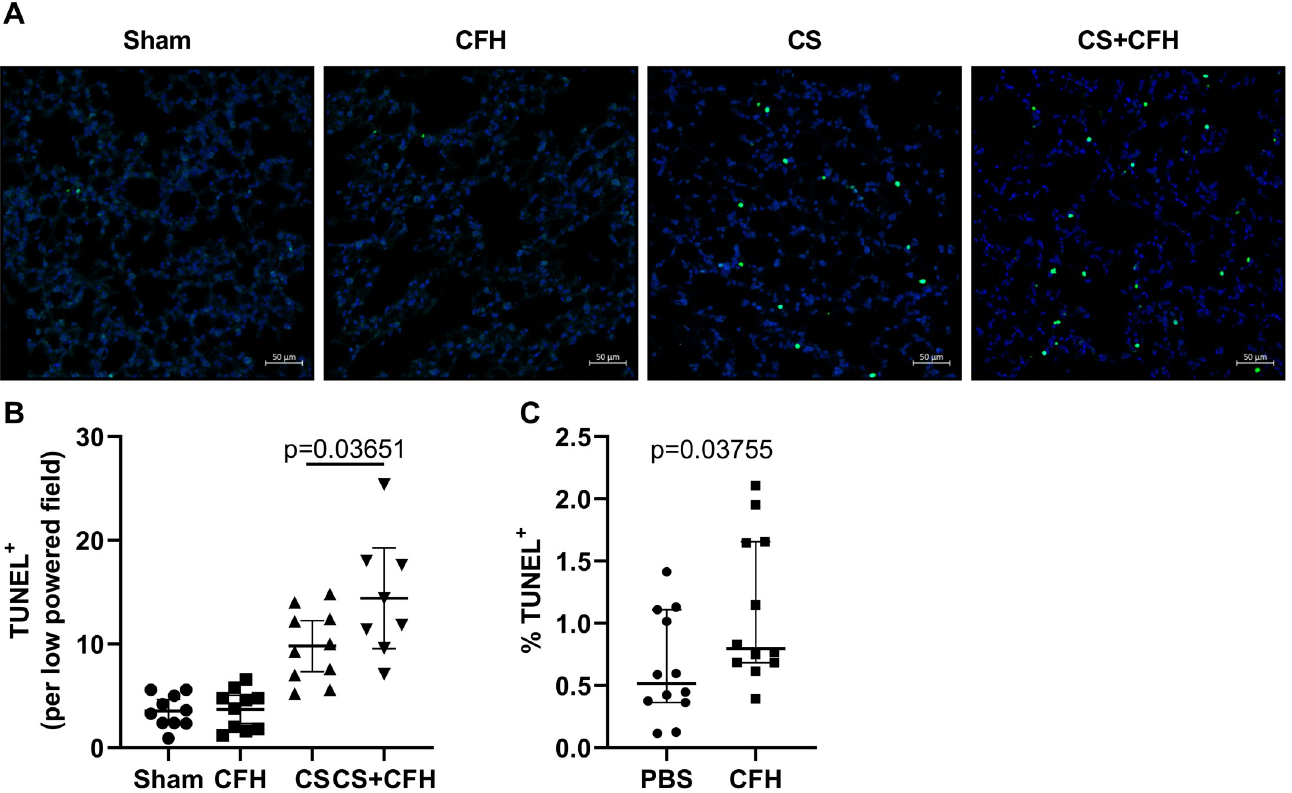
Fig 5. CFH increases lung endothelial apoptosis in sepsis. (A) Formalin fixed mouse lung tissue was stained for TUNEL (green) with nuclear DAPI staining (blue). (B) The number of TUNEL positive cells was higher in CS+CFH versus CS alone by blinded quantification of low powered images (n = 8–10, p = 0.03651). (C) We also assessed apoptosis by TUNEL staining of HULECs in culture and found that CFH (1 mg/mL) treatment induced apoptosis at 4 hours (n = 12, p = 0.03755).